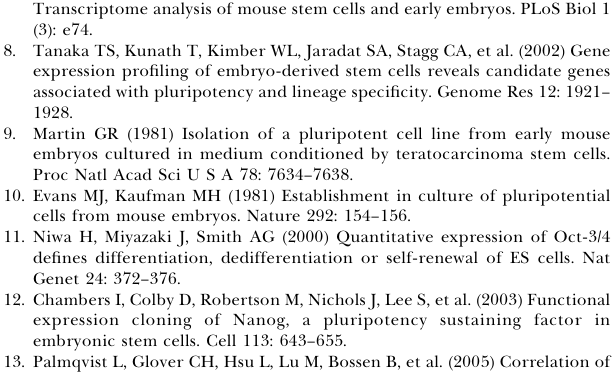
Table S1. Confidence Values for All Genes in the R1–LR Dataset Found at doi:10.1371/journal.pcbi.0020158.st001 (686 KB PDF). Table S2. Confidence Values for All Genes in the DMSO/RA Dataset and M–LR Dataset Found at doi:10.1371/journal.pcbi.0020158.st002 (859 KB PDF). Table S3. The First Five Pareto Fronts Table S4. Raw Data from Q–RT–PCR Table S5. Biological Process and Molecular Function Classification of Genes in Pareto Fronts Found at doi:10.1371/journal.pcbi.0020158.st005 (8 KB PDF).